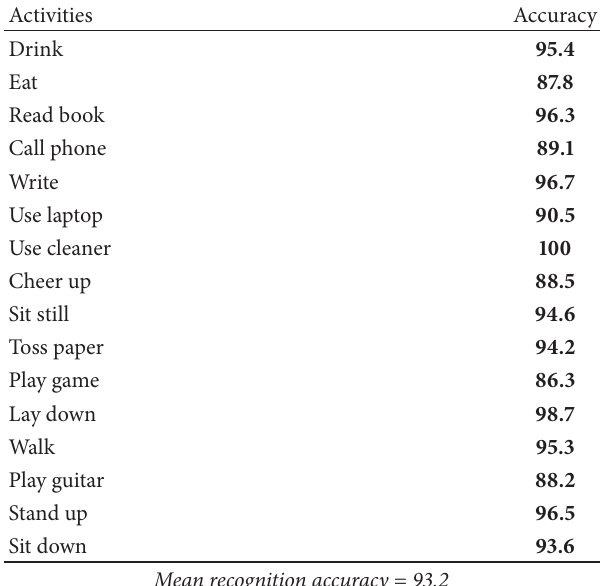
Table 3: Comparison of recognition accuracy of proposed method and state-of-the-art methods using MSRAction3D dataset.